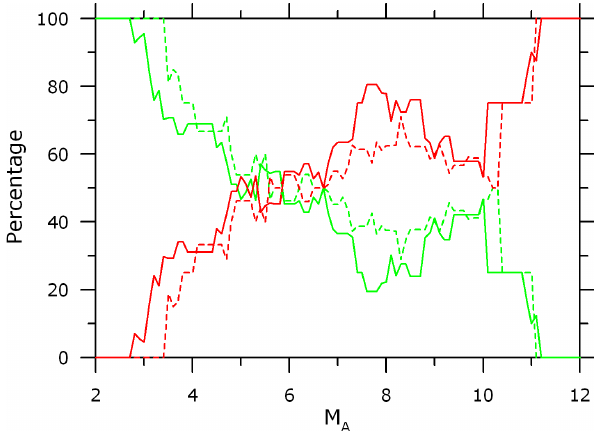
Fig. 5. Dependence of percentage of stationary (green lines) and nonstationary (red lines) shocks on the proxy of perpendicular Alfv´en Mach number (solid lines) and on the solar wind Alfv´en Mach number (dashed lines). To decrease statistical scattering, the number of shocks is calculated for Mach number intervals of length 2 for each point shown on the